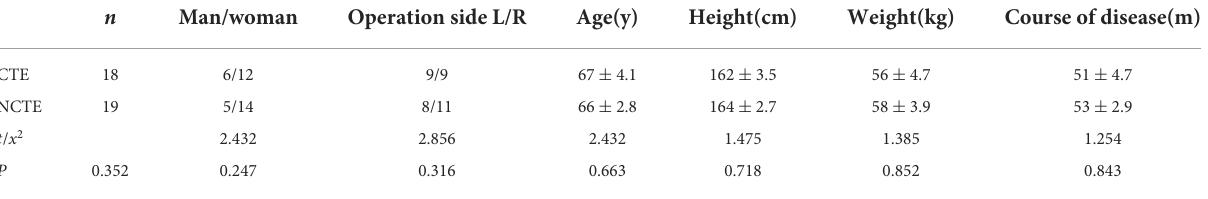
TABLE 1 Preoperative basic information of